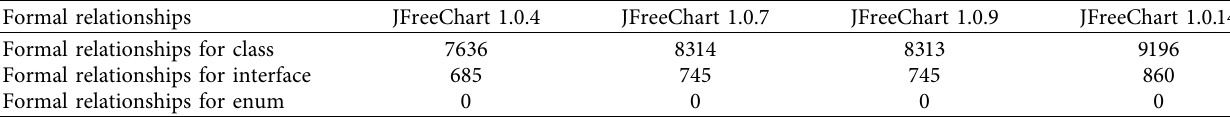
Table 12: Formal relationships in JFreeChart.